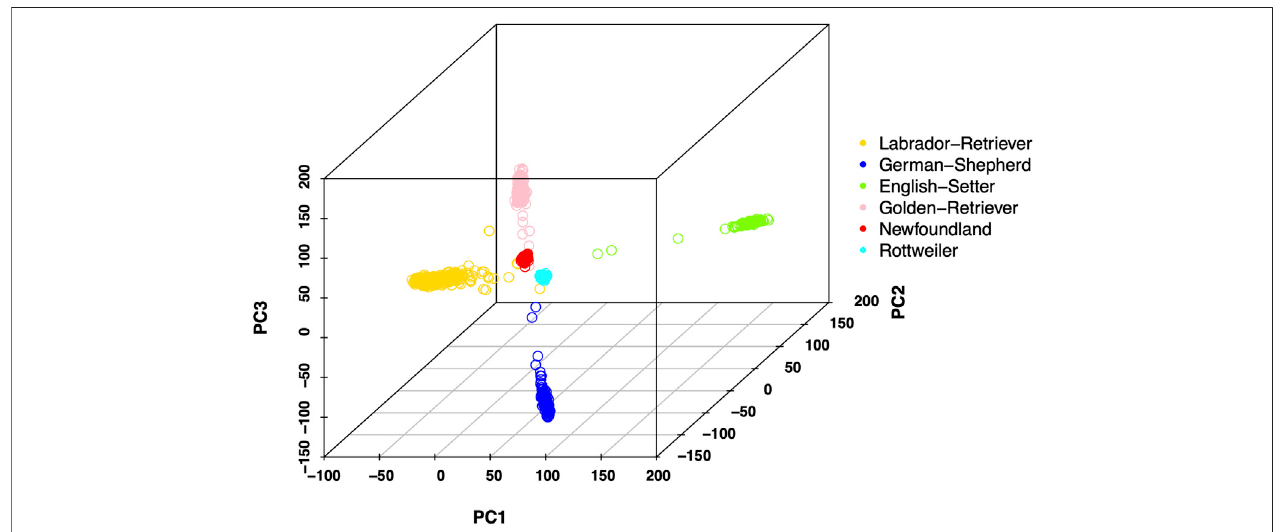
FIGURE 1 | Principal component (PC) plot of all samples. The fi rst 3 PCs are used to show the genetic relationship of different breeds. All breeds are marked by a different color.